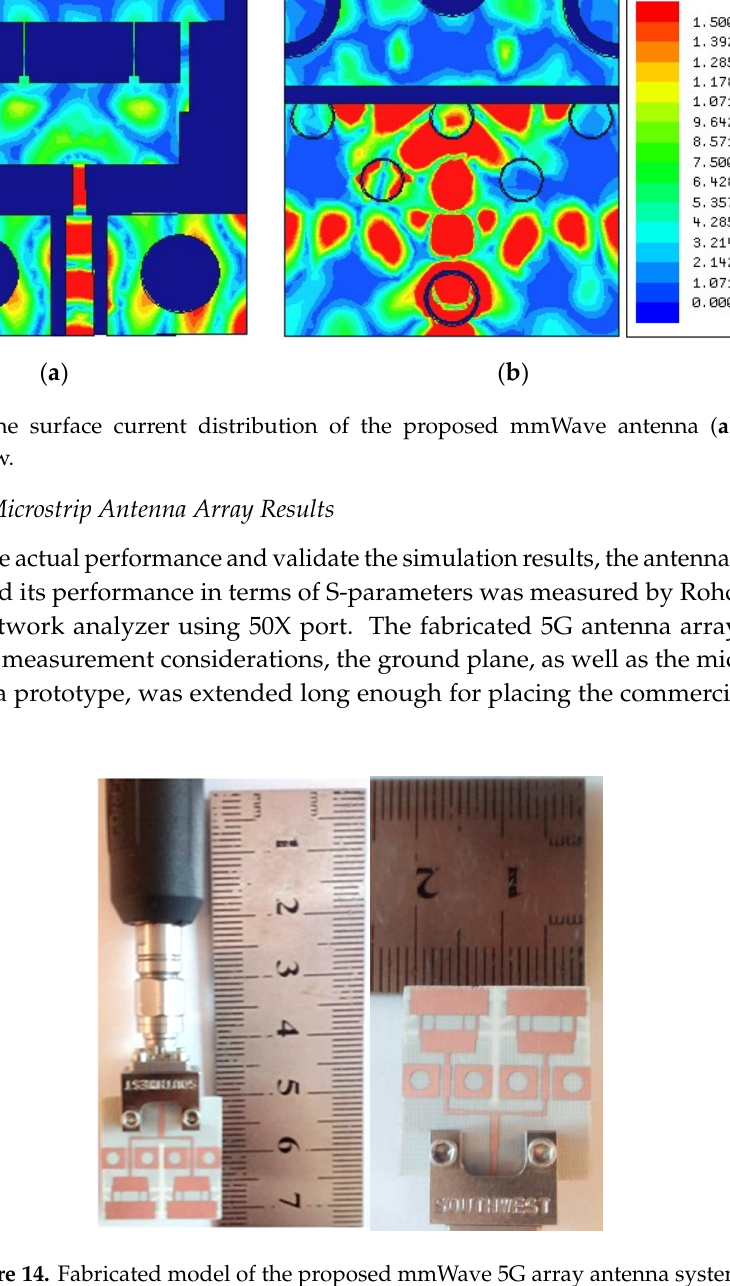
Figure 12. Simulated radiation characteristics of a single patch antenna ( a ) 2-D radiation pattern; ( b ) 3-D radiation pattern.